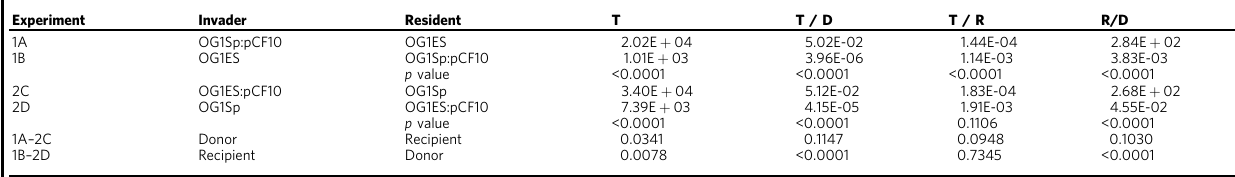
Table 1 Numbers of transconjugants (T), transconjugants/donor (T/D), transconjugants/recipient (T/R), and recipient/donor (R/D) ratio on Day 1 after inoculation of the invading strain.